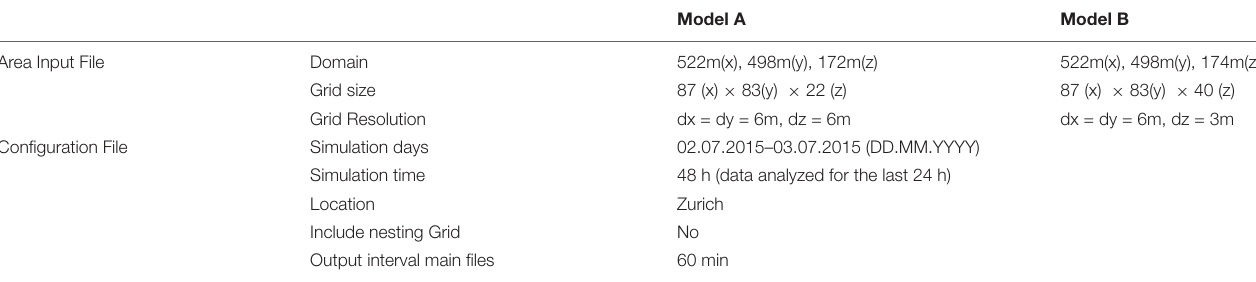
TABLE 1 | ENVI-met model settings.